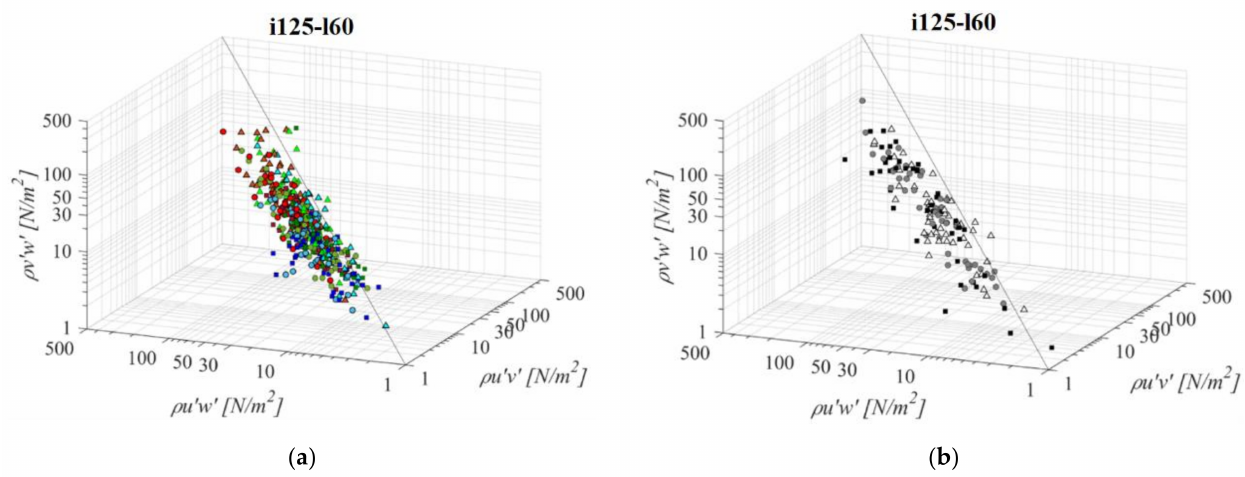
Figure 6. 3D scatterplot of concurrent RSS components for the i125l60 fishway configuration: ( a ) pool-orifice type fishway and ( b ) vertical slot fishway.